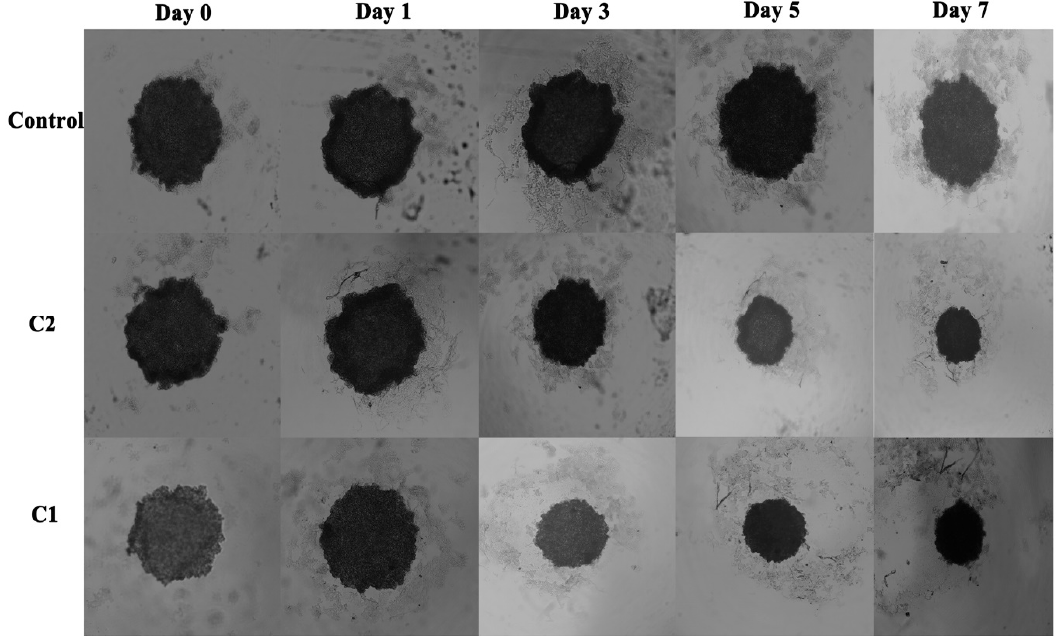
Figure 3. Tumor spheroid analysis of A-549 cells after being treated with C1 and C2 with specified concentrations for 7 days.